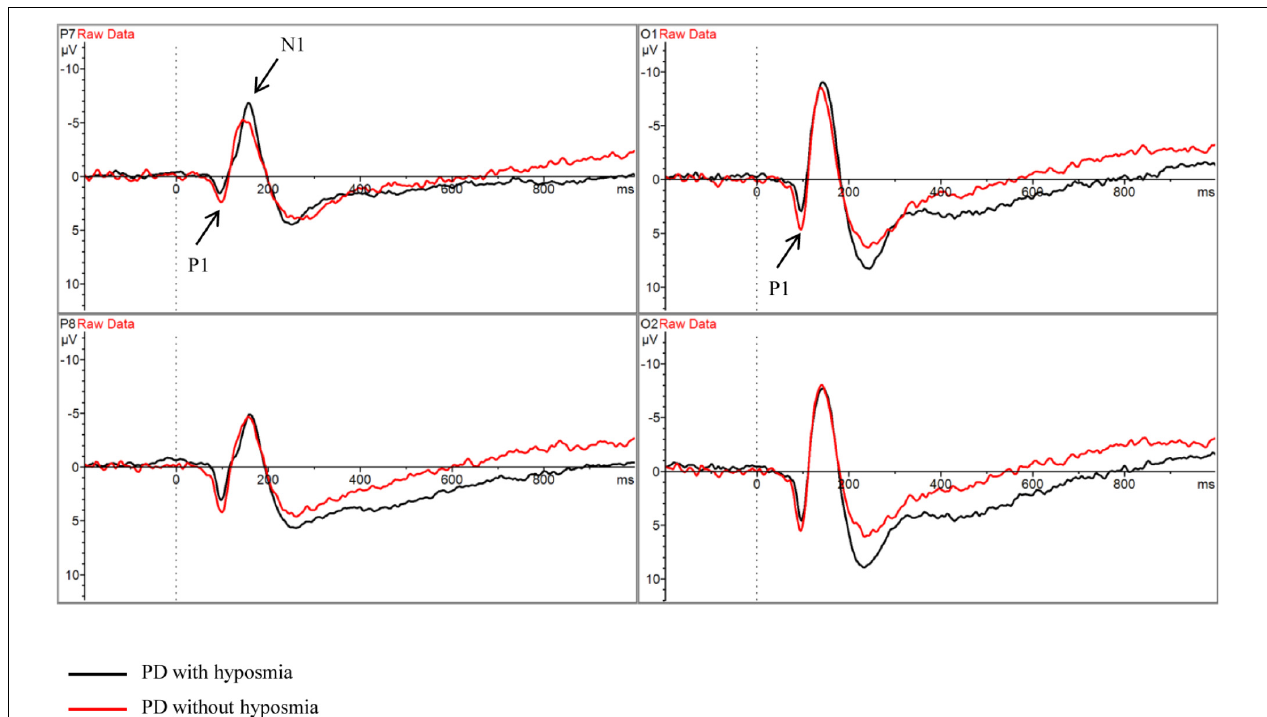
FIGURE 2 | Grand average ERP waveform in PD with hyposmia (black line) and PD without hyposmia (red line) during retrieval period in DMS task. Latency was recorded in milliseconds with stimulus onset at 0. Amplitude was recorded in micro-voltage.